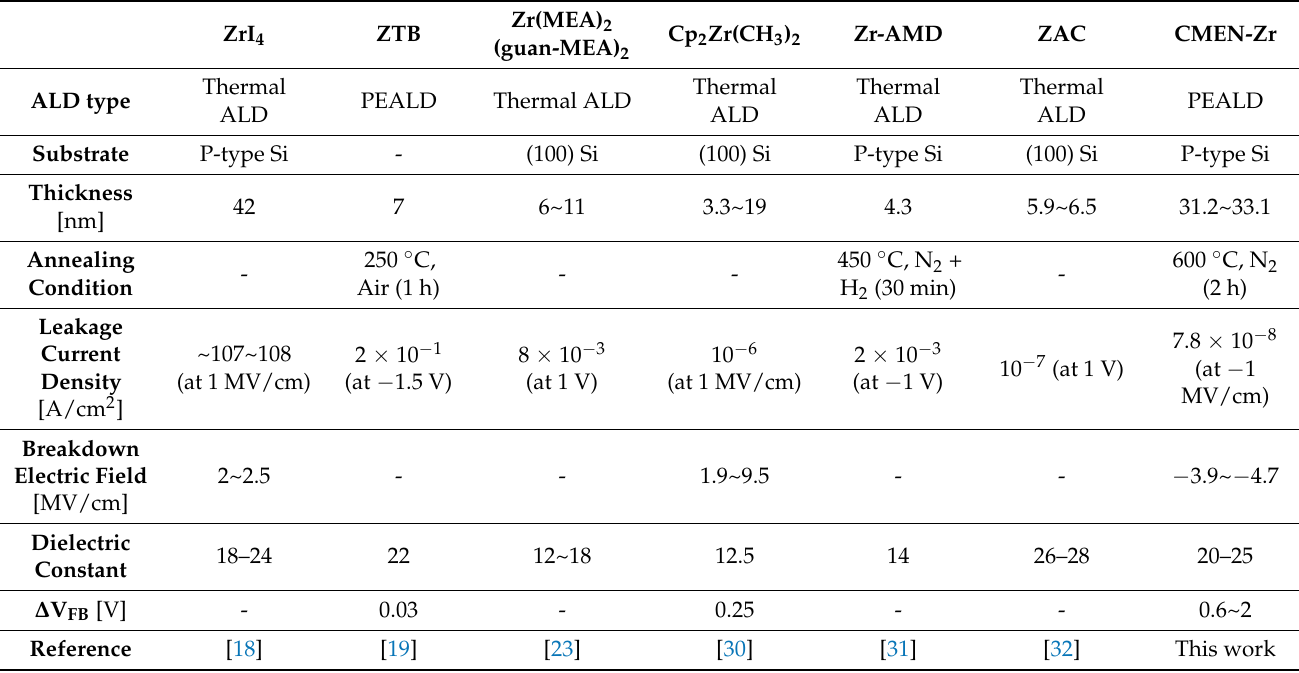
Table 1. Summarized electrical and dielectric characteristics obtained from the current ZrO 2 and reported ZrO 2 thin